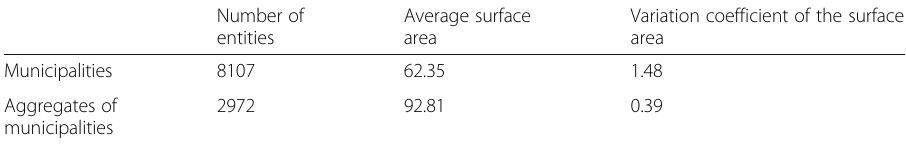
Table 2 Descriptive statistics of municipalities and